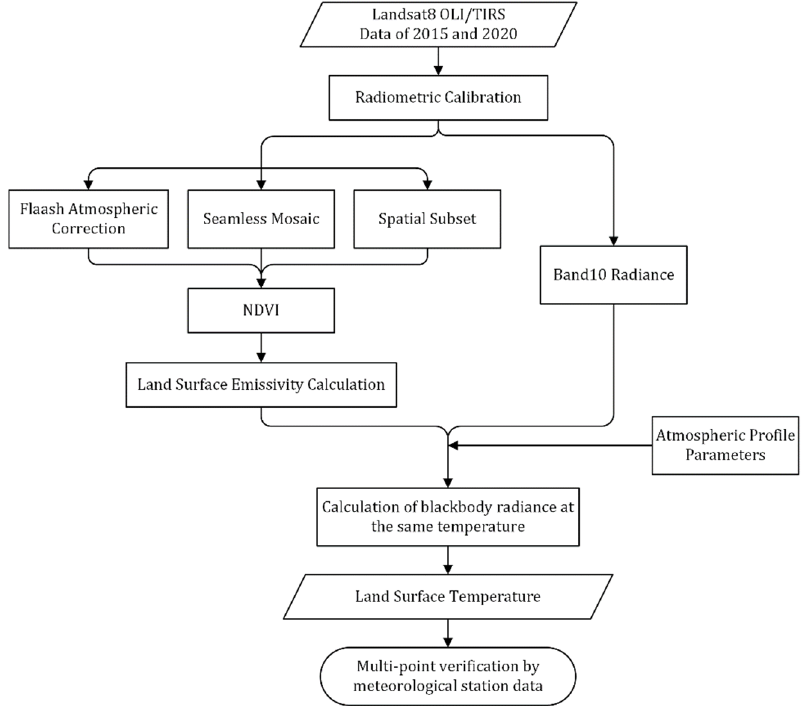
Figure 2. Diagram of land surface temperature retrieval process.